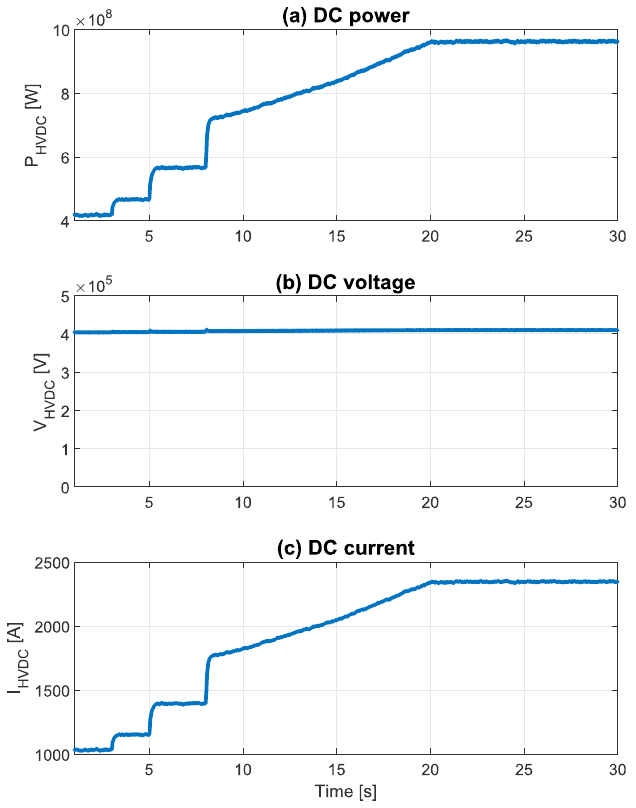
Figure 15. ( a )Reactivepowerand( b )q-axiscurrentssuppliedbytheindividualinverters; ( c )gridfrequency. Figure 15. ( a ) Reactive power and ( b ) q-axis currents supplied by the individual inverters; ( c ) grid frequency.